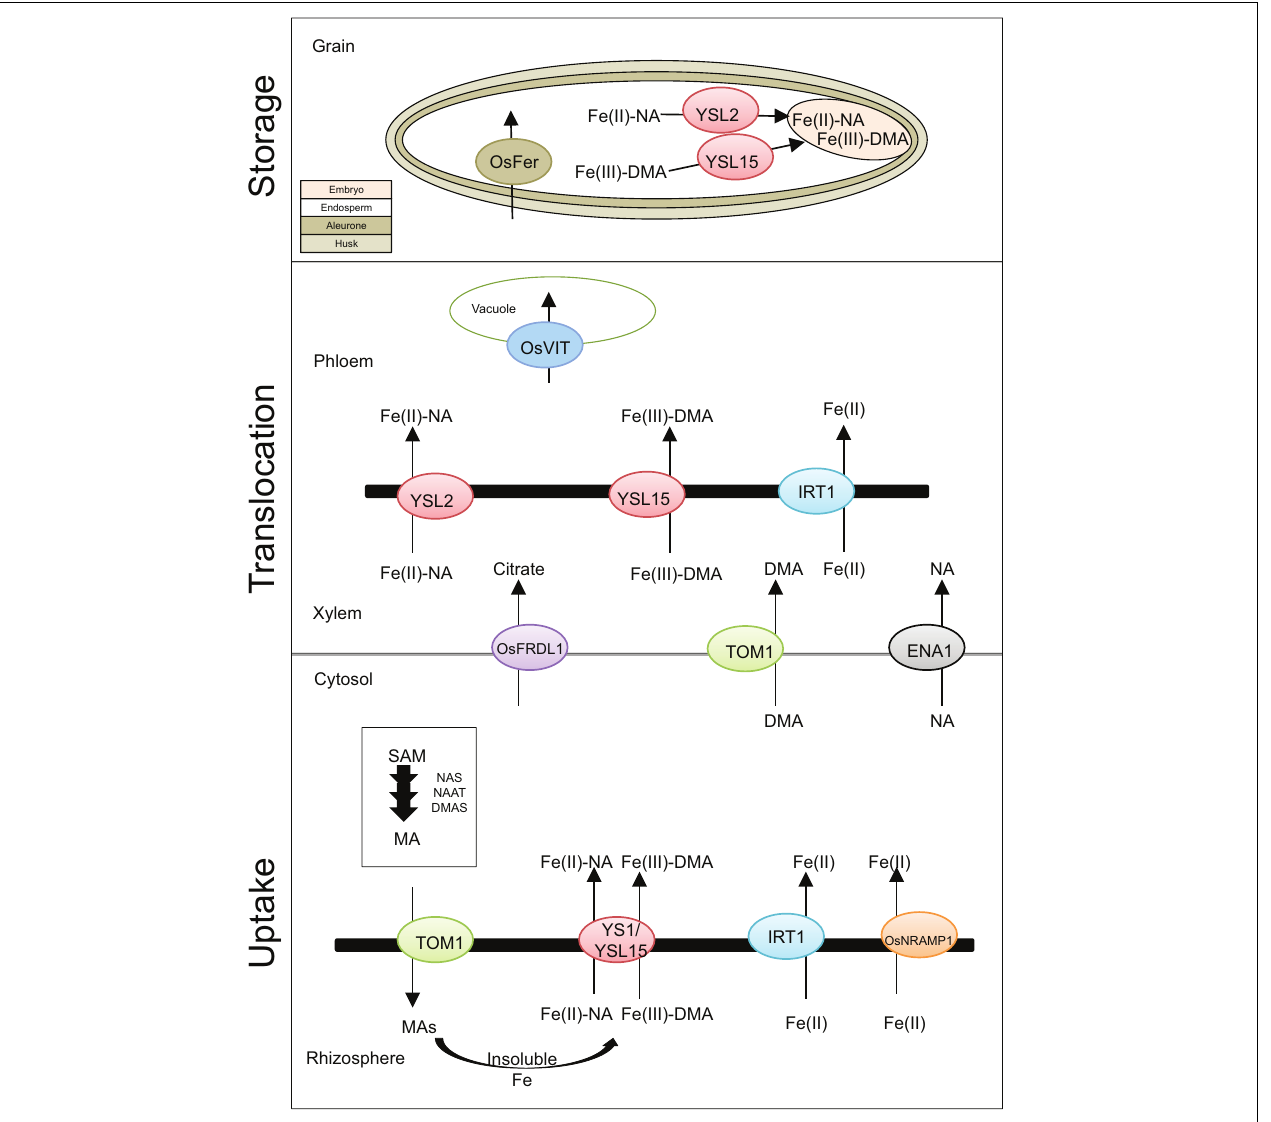
FIGURE 1 | Basic scheme of iron uptake, translocation, and storage in rice. Presented are known genes involved in iron uptake and transport within the rice plant. TOM1, transporter of mugineic acid family phytosiderophores 1; YS1, yellow strip1; YSL15, yellow stripe 1-like; IRT1, iron-regulated transporter; OsNRAMP1, natural resistance-associated macrophage protein 1; OsFRDL1, ferric reductase defective like1; ENA, efflux transporter of nicotianamine; OsVIT, vacuolar iron transporter; OsFER, ferritin; MA, mugineic acid; DMA, 2 (cid:48) -deoxymugineic acid; NA, nicotianamine; SAM, S -adenosyl-L-methionine; NAS, nicotianamine synthase; NAAT, nicotianamine aminotransferase; DMAS, deoxymugineic acid